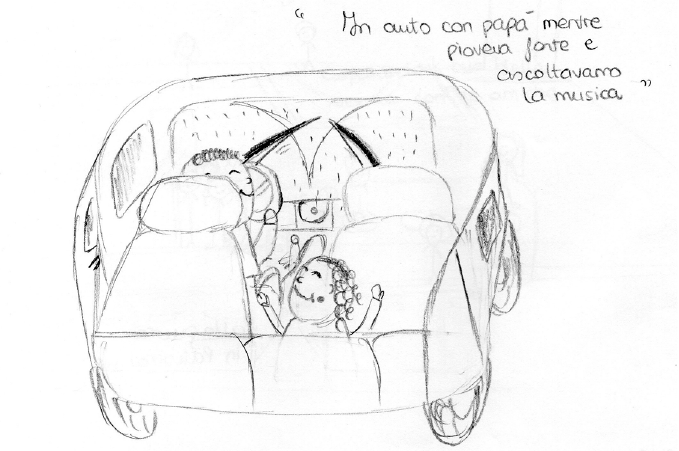
Figure 1. Drawing, referring to infancy, entitled “In the car with my dad while it rained heavily and we listened to music”.